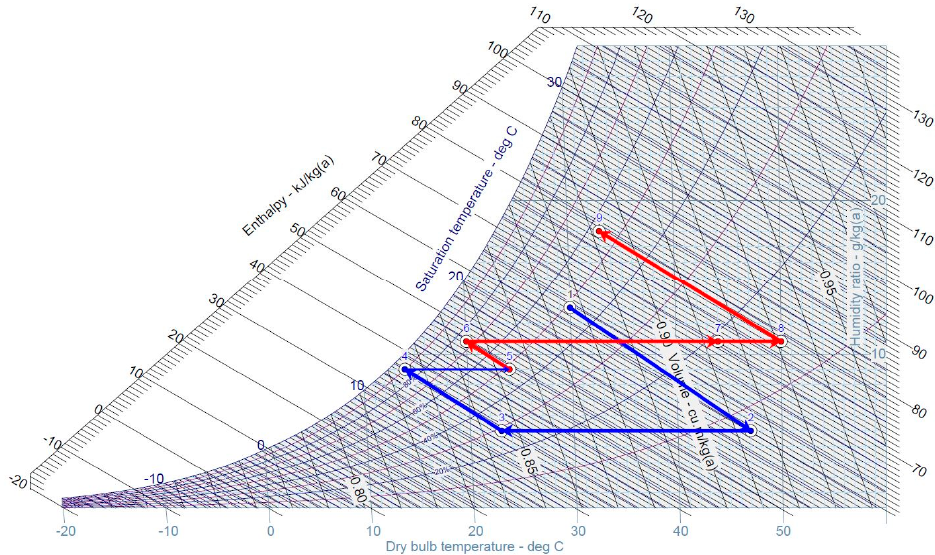
Figure 5. Psychrometric chart of the SDEC system air processing stages.